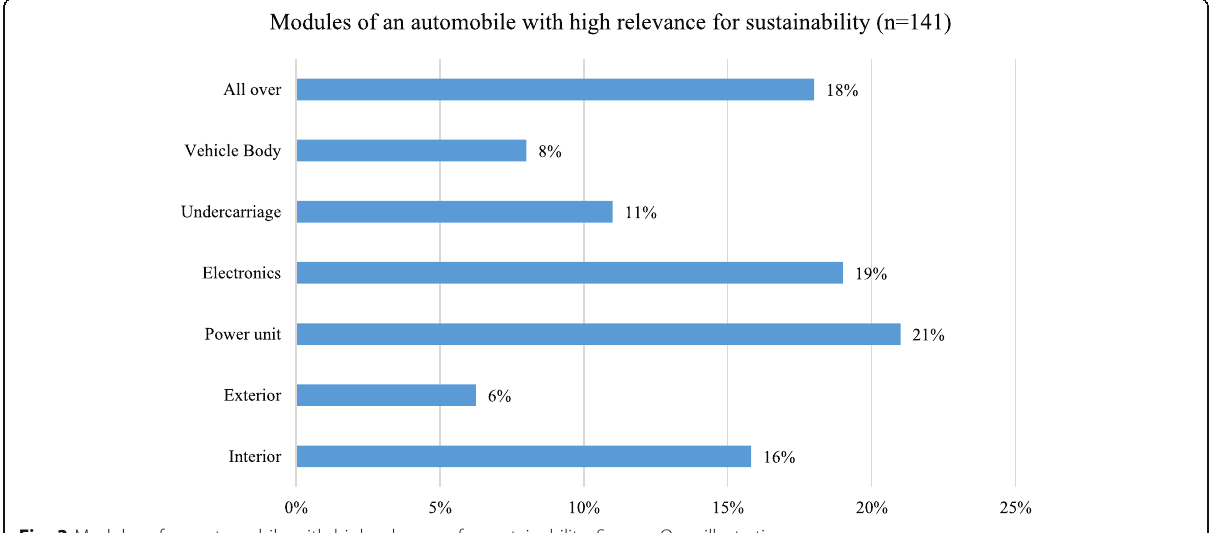
Fig. 3 Modules of an automobile with high relevance for sustainability. Source: Own illustration